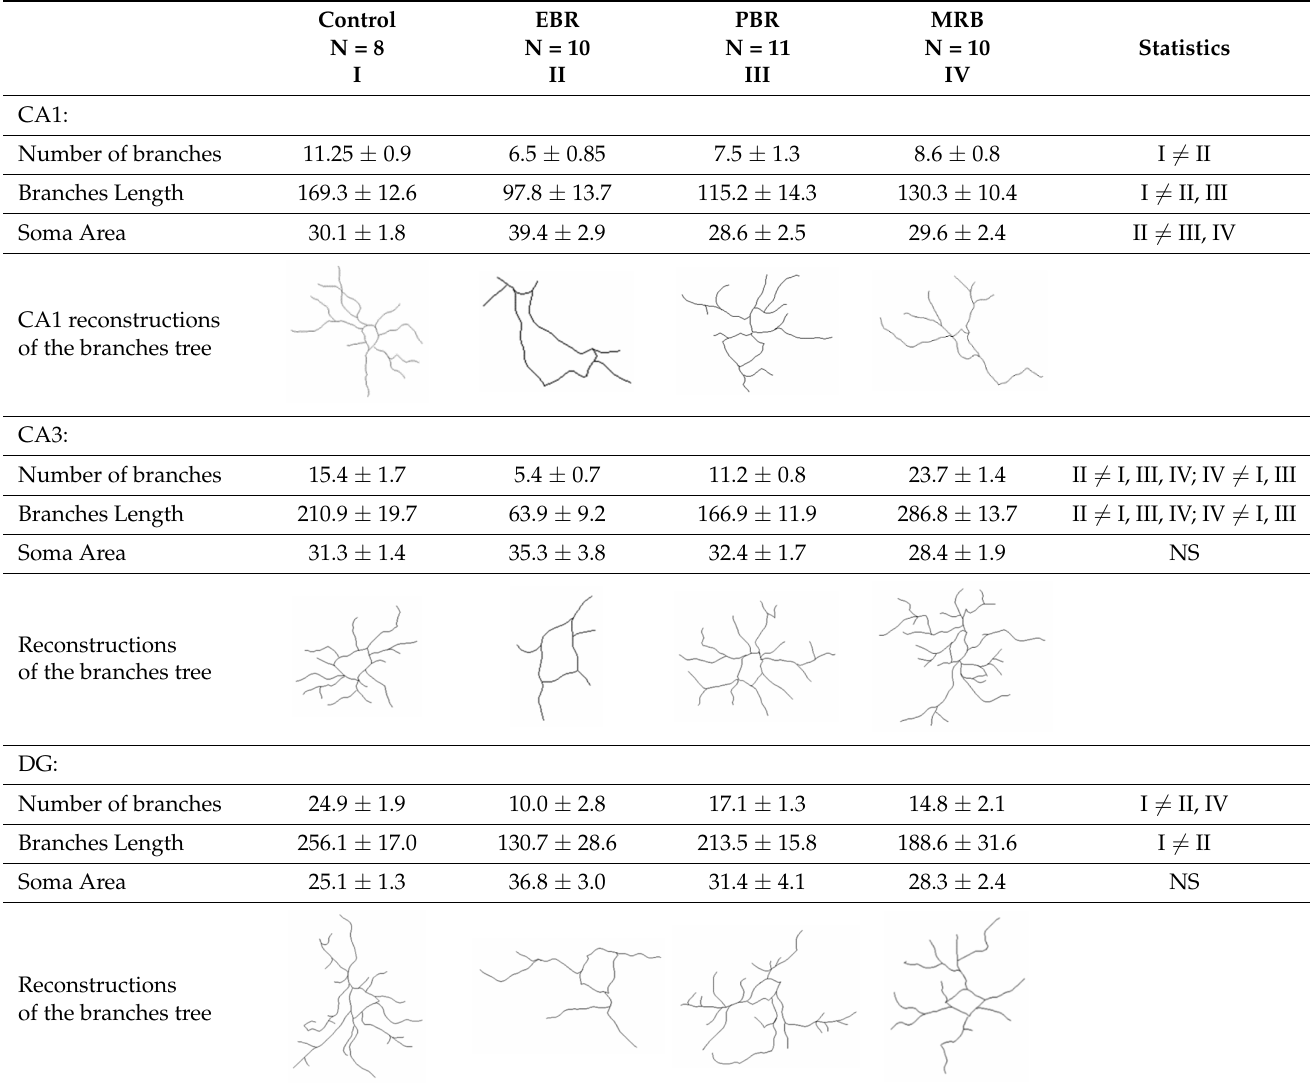
Table 1. Quantitative analysis of total microglia number total microglia length (mm), soma size and computer-generated plots of reconstructions of the branches tree in CA1 area in sham-PSS controls, animals with an extreme behavioral response (EBR) or partial response (PBR) to the PSS exposure, and in animals whose behavior was minimally affected by the stressor (MBR). All data represent the group means ± S.E.M. NS = Not